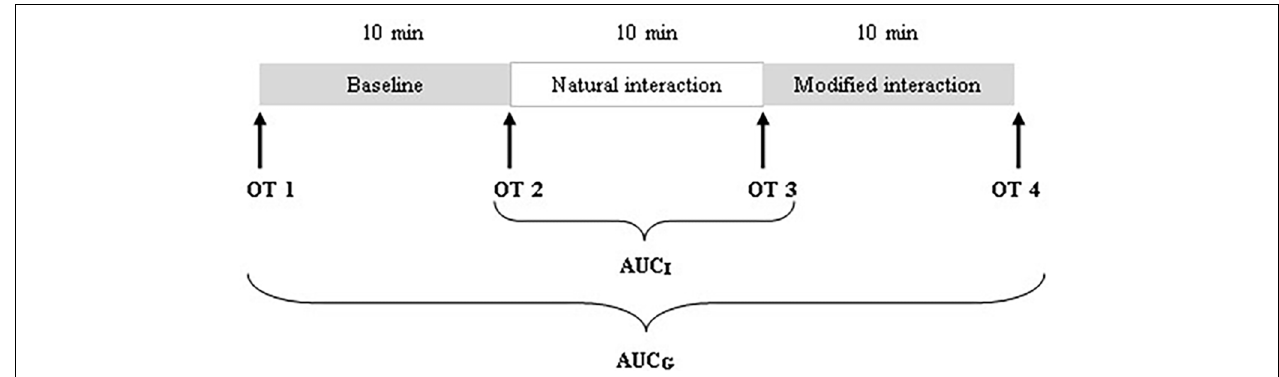
FIGURE 1 | Schematic diagram of the procedure and saliva collection